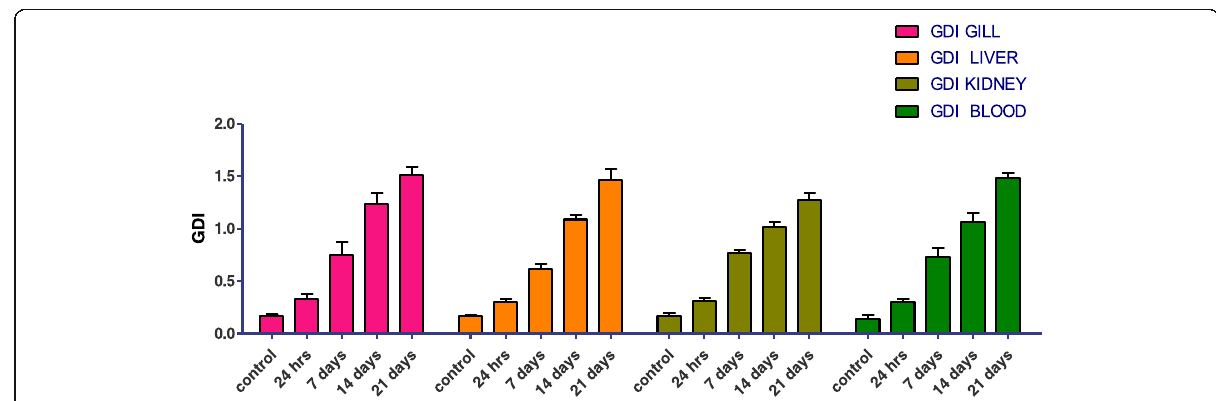
Fig. 11 Genetic damage index (GDI) in the tissues of C. carpio during sub-lethal exposure to